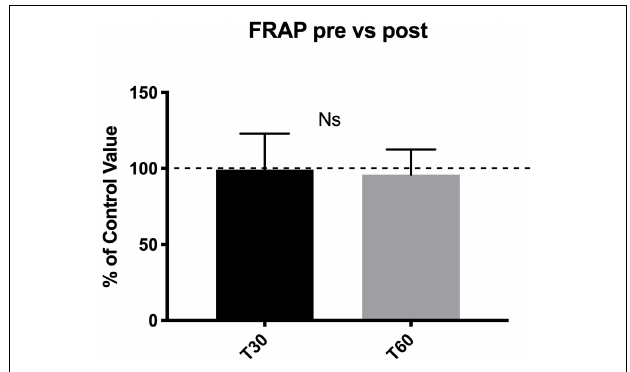
FIGURE 4 | No statistical difference in TAC levels were found between pre- and post-dive values at T30 and T60.